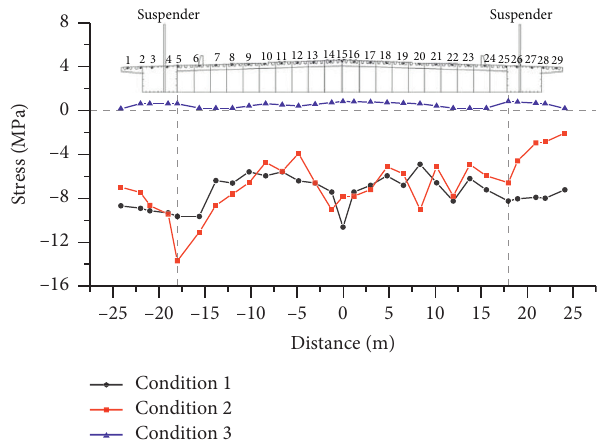
Figure 12: Longitudinal stress distribution of top plate.